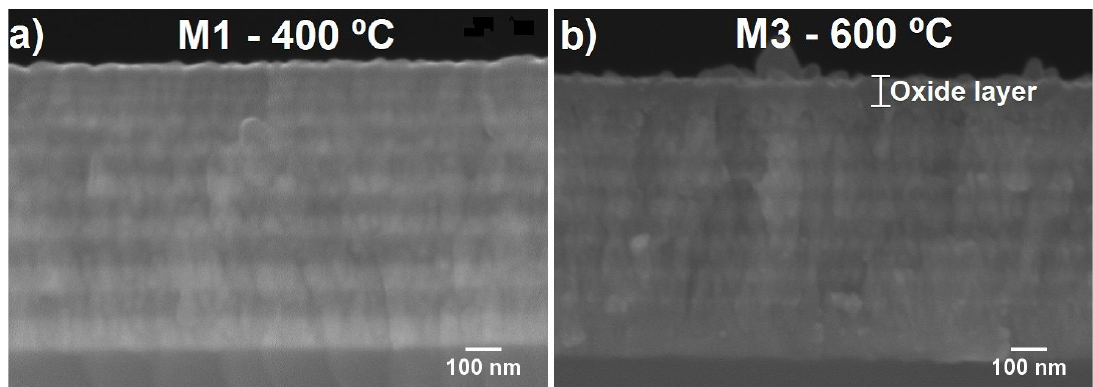
Figure 8. Cross-section SEM images with magnification of 50000x acquired after oxidation tests at (a) 400 ºC and (b) 600